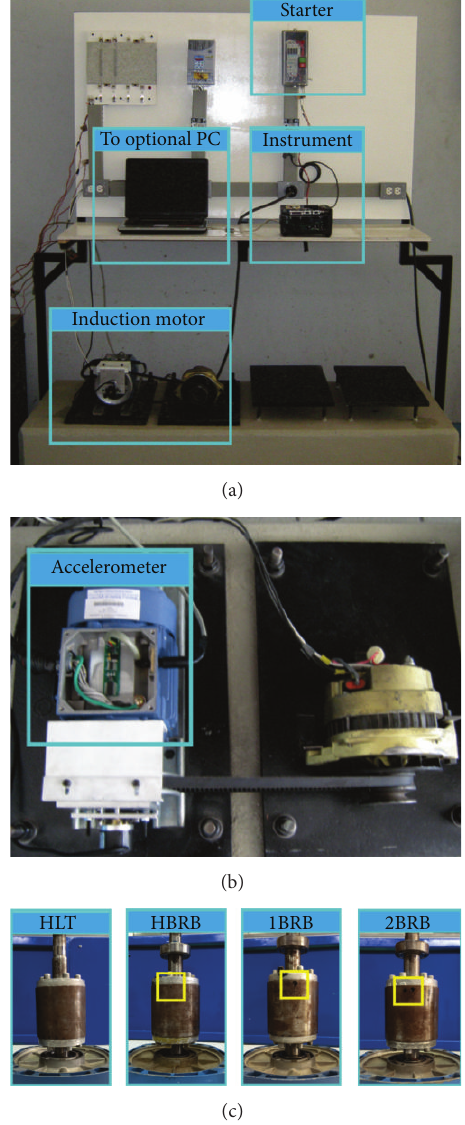
Figure 7: Experimentation: (a) experimental setup, (b) top view accelerometer, and (c)